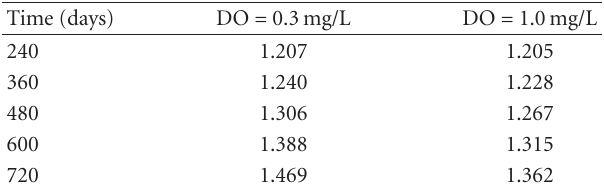
Table 1: Variation of DOC with two di ff erent DO concentrations for a well of 150